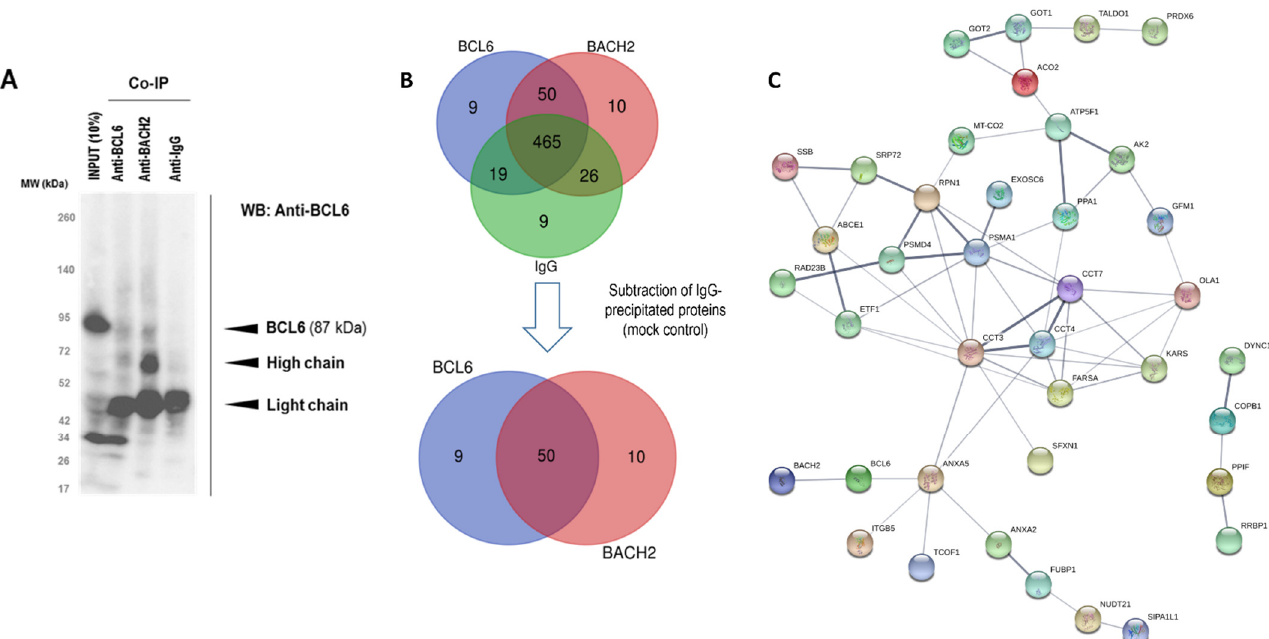
Figure 7. BACH2/BCL6 interactions, proteins that exclusively associate with BACH2 and BCL6 detected from the co-immunoprecipitation and subsequent MS studies. ( A ) Immunoprobing of BCL6 presence in co-immunoprecipitation (Co-IP) obtained with application of anti-BCL6, anti-BACH2, and anti-IgG (control) in MEC-1 cells (uncropped WB original image see Figure S9), ( B ) identification of proteins interacting with BCL6 or BACH2 with mass spectrometry (MS)—Orbitrap analyses, and ( C ) protein–protein interaction networks of BACH2 and BCL6.